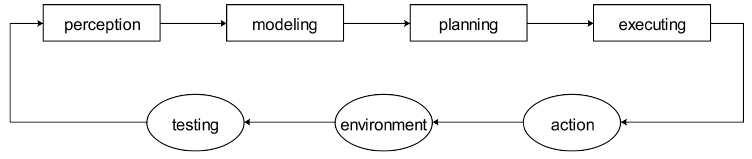
Figure 4. The knowledge-based